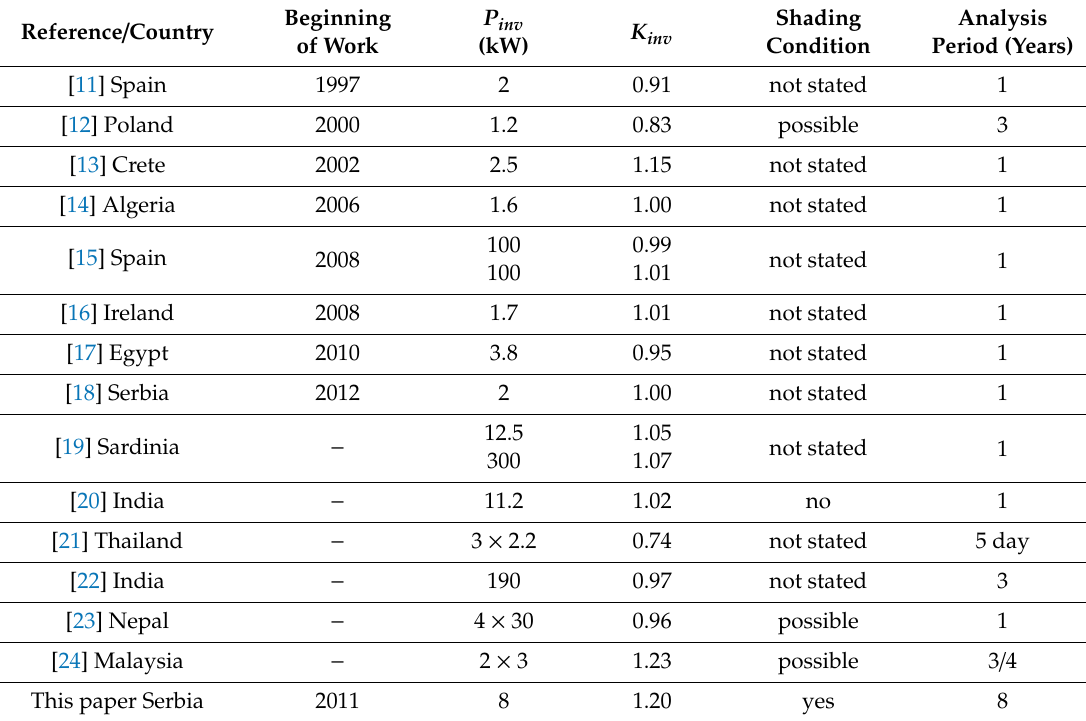
Table 1. The PV power plants analyzed by the